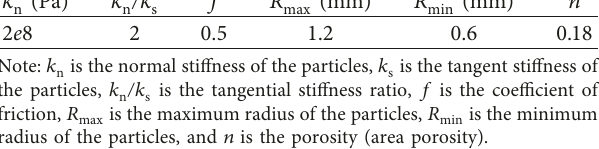
Table 2: Microscopic parameters of samples at the initial state. k n